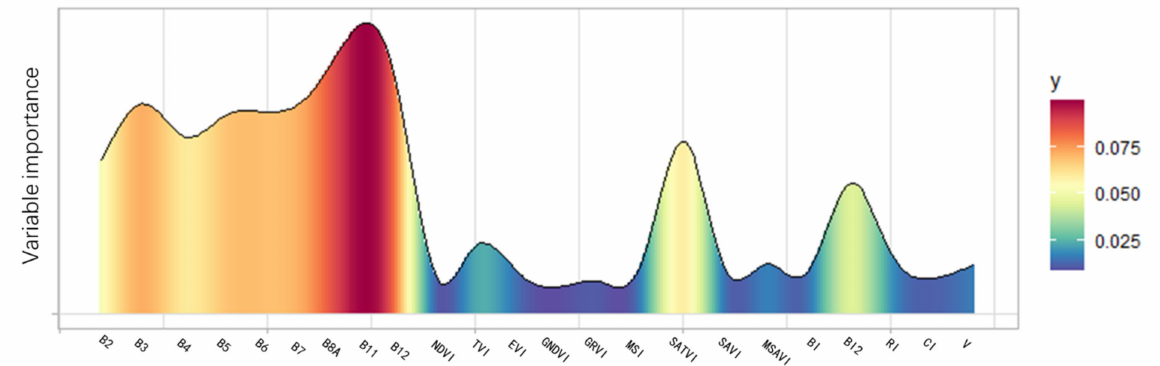
Figure 4. Distribution of variance importance in projection values for bands and all spectral